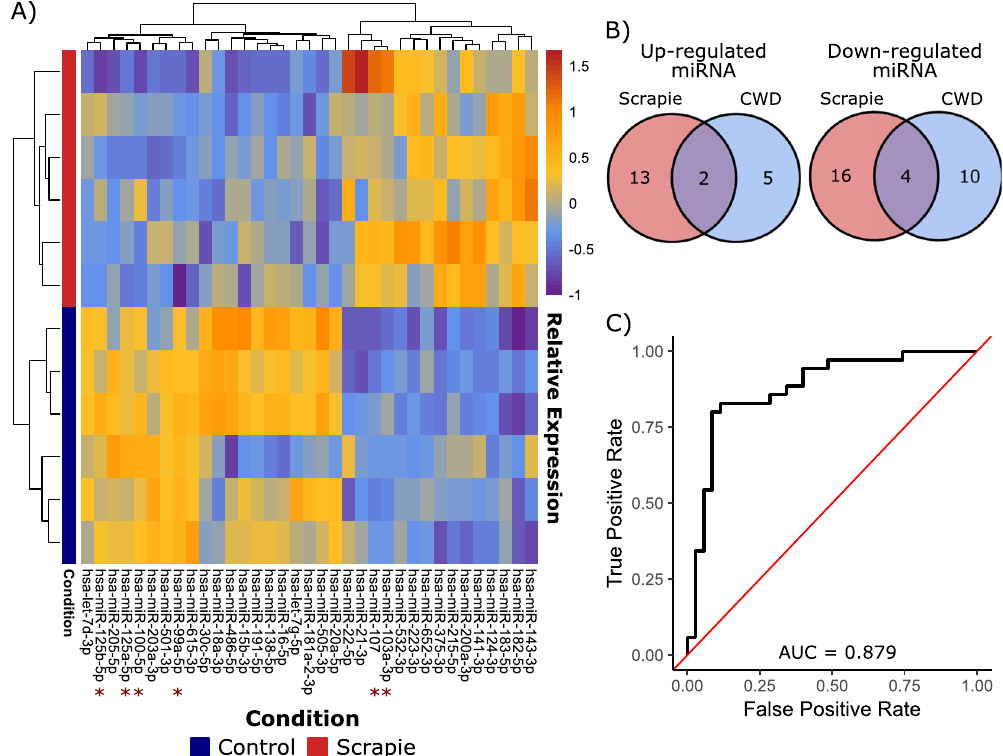
Figure 6. Serum miRNA are also biomarkers of prion infection in scrapie-infected hamsters. A subset of serum miRNA biomarkers of CWD in elk showed similar alterations in abundance in scrapie-infected hamsters. ( A ) Scrapie-infected hamster samples cluster together based on expression of serum miRNA biomarkers. The 6 biomarkers common to CWD positive elk and scrapie-infected hamsters are highlighted by a red asterisk ( * ). ( B ) A signature of 6 altered serum miRNAs is common to CWD-infected elk and scrapie-infected hamsters. ( C ) Lasso penalized logistic regression was used to model elk CWD status using the expression of 5 of the 6 conserved miRNAs (hsa-miR-103a-3p, hsa-miR-107, hsa-miR-99a-5p, hsa-miR-125b-5p and hsa-miR-100-5p) in 70 elk serum samples. ROC analysis revealed that this model was able to correctly identify CWD status in the majority of elk samples.